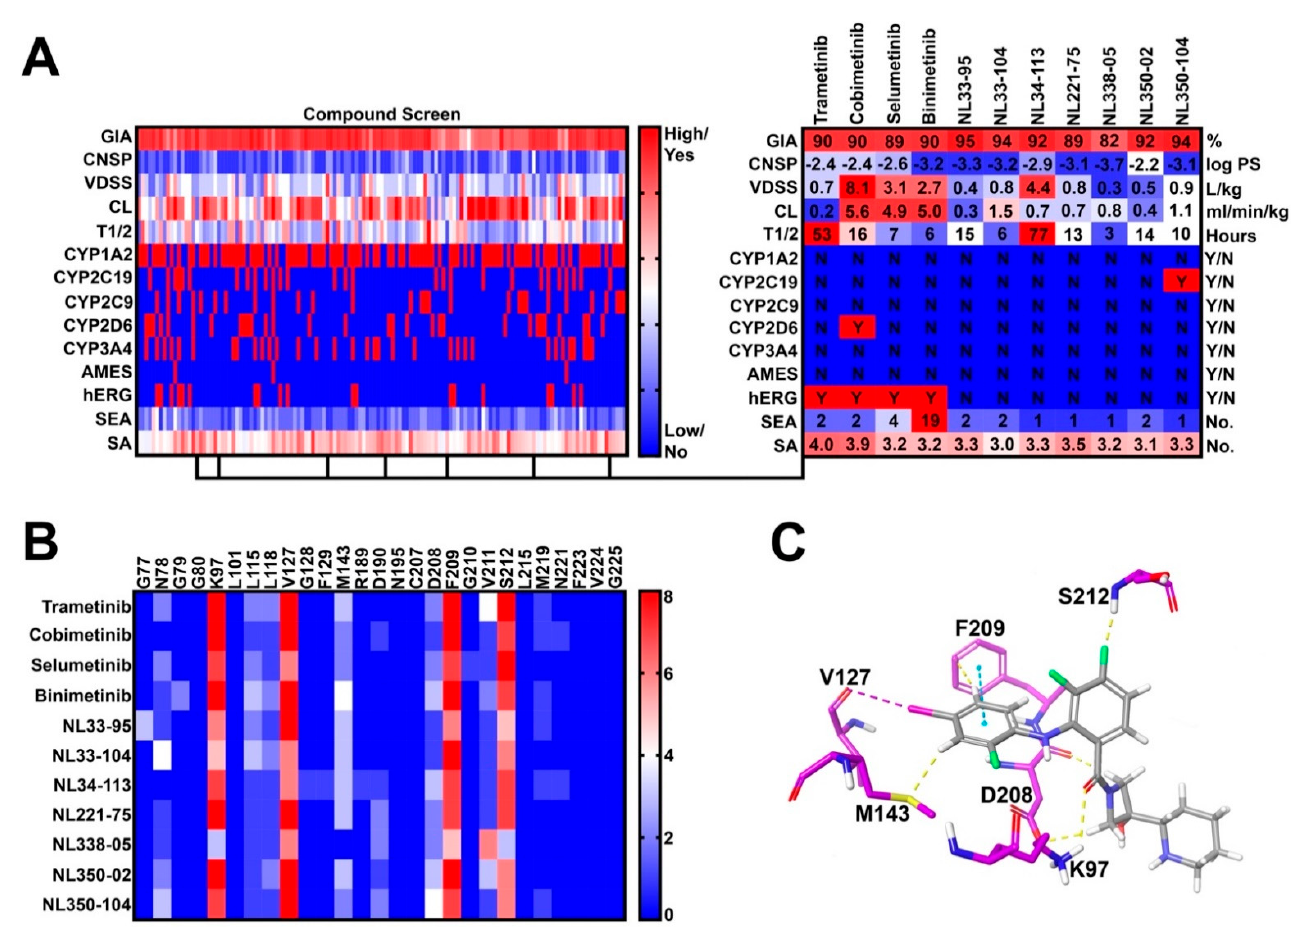
Figure 2. Virtual compound screen using pharmacokinetic (PK) prediction tools: ( A ) a total of 27 novel side chains were conjugated to five synthetic intermediates. Compounds were screened for pharmacokinetic properties as previously described. Seven compounds were identified with favorable PK profiles and were selected for molecular docking; ( B ) frequency of drug-allosteric site amino acid interactions quantified from the top 10 most energetically favorable docking poses. Key interactions include lysine-97 (K97), valine-127 (V127), phenylalanine-209 (F209), and serine-212 (S212); and ( C ) visual representation of cobimetinib interacting with key amino acids in the MEK1 allosteric